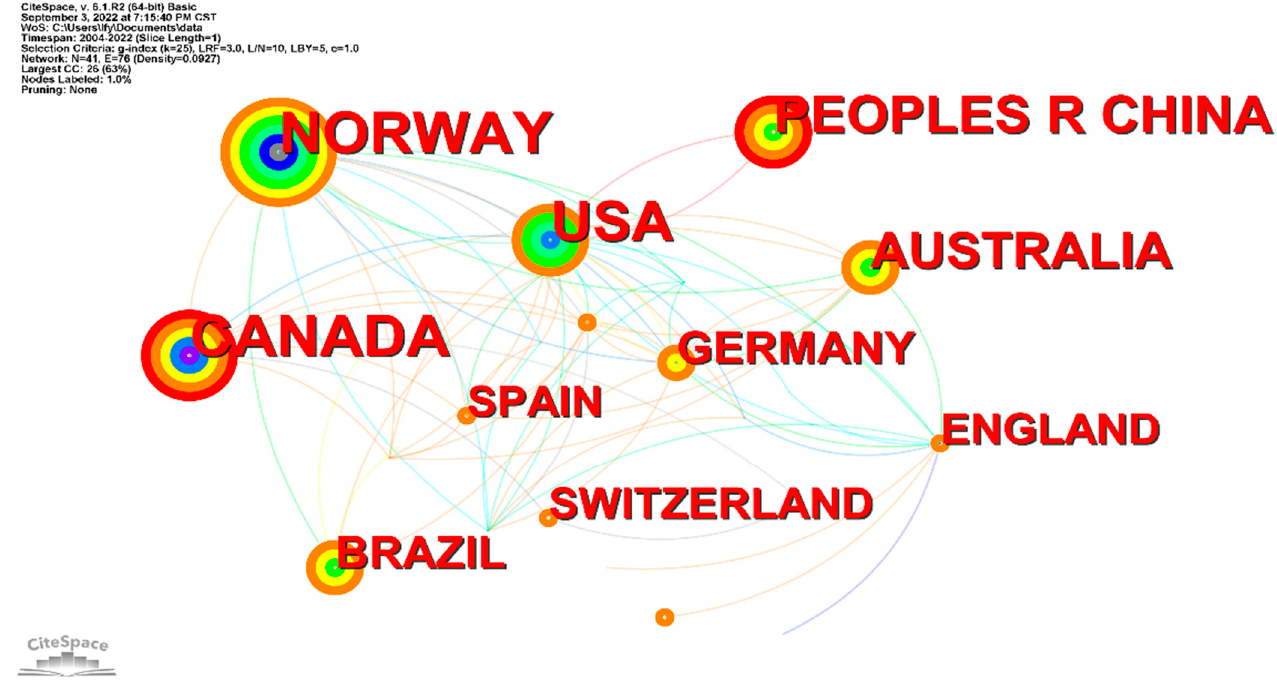
Figure 4. Countries collaboration chart.